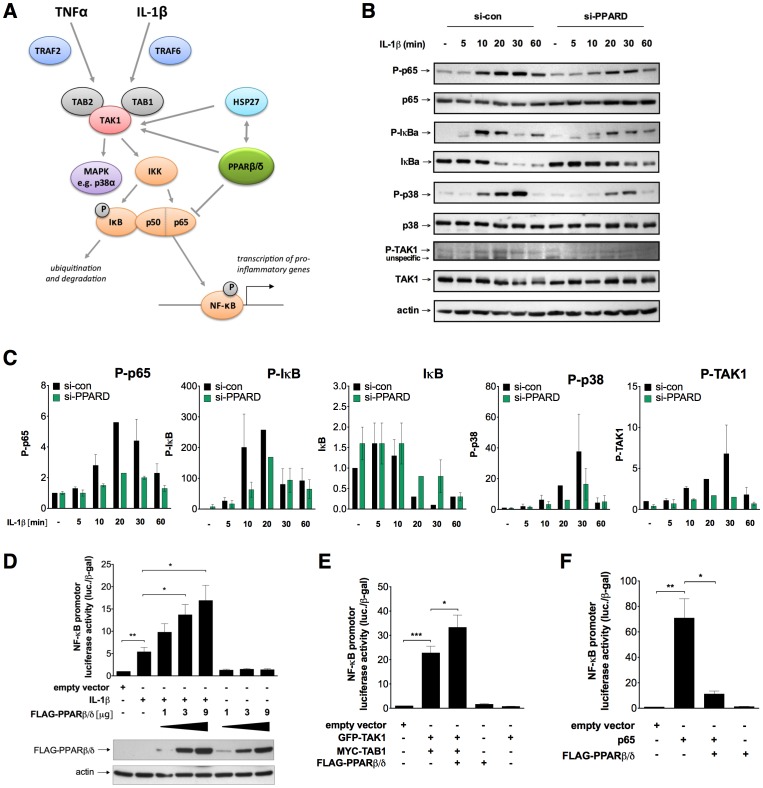
Modulation of TAK1-mediated signaling to NFκB by PPARβ/δ.(A) Components of cytokine-induced TAK1 signaling and effects of PPARβ/δ identified in the present study. (B) Immunoblot analysis of the indicated proteins at different time points after IL-1β stimulation of si-con and si-PPARD treated HeLa cells. P-p65: p65 phosphorylated at serine-536, P-IκB: serine 32; P-p38: threonine-180 and tyrosine-182; P-TAK1: threonine-187. The siRNA effect on PPARβ/δ protein levels in this experiment is shown in Figure S1. (C) Quantification of data obtained by immunoblotting for phosphorylated p65, IκB, p38 and TAK1 as in panel B. Values for phosphoproteins were normalized to signals measured for total protein levels. (D) Effect of PPARβ/δ overexpression on IL-1β induced NFκB activity. HeLa cells were transfected with a NFκB-luciferase reporter plasmid and FLAG-PPARβ/δ expression vector or empty vector, and treated with IL-1β for 4 h as indicated. Luciferase activities were determined in cell lysates and normalized to β-galactosidase expressed from a cotransfected CMV-lacZ plasmid. (E) Effect of PPARβ/δ overexpression on TAK1/TAB1-induced NFκB activity. Experimental setup as in panel D, expect that TAK1 and TAB1 expression vectors were used instead of IL-1β. (F) Effect of PPARβ/δ overexpression on p65-induced NFκB activity. Experimental setup as in panel D, expect that a 65 expression vector was used instead of IL-1β.